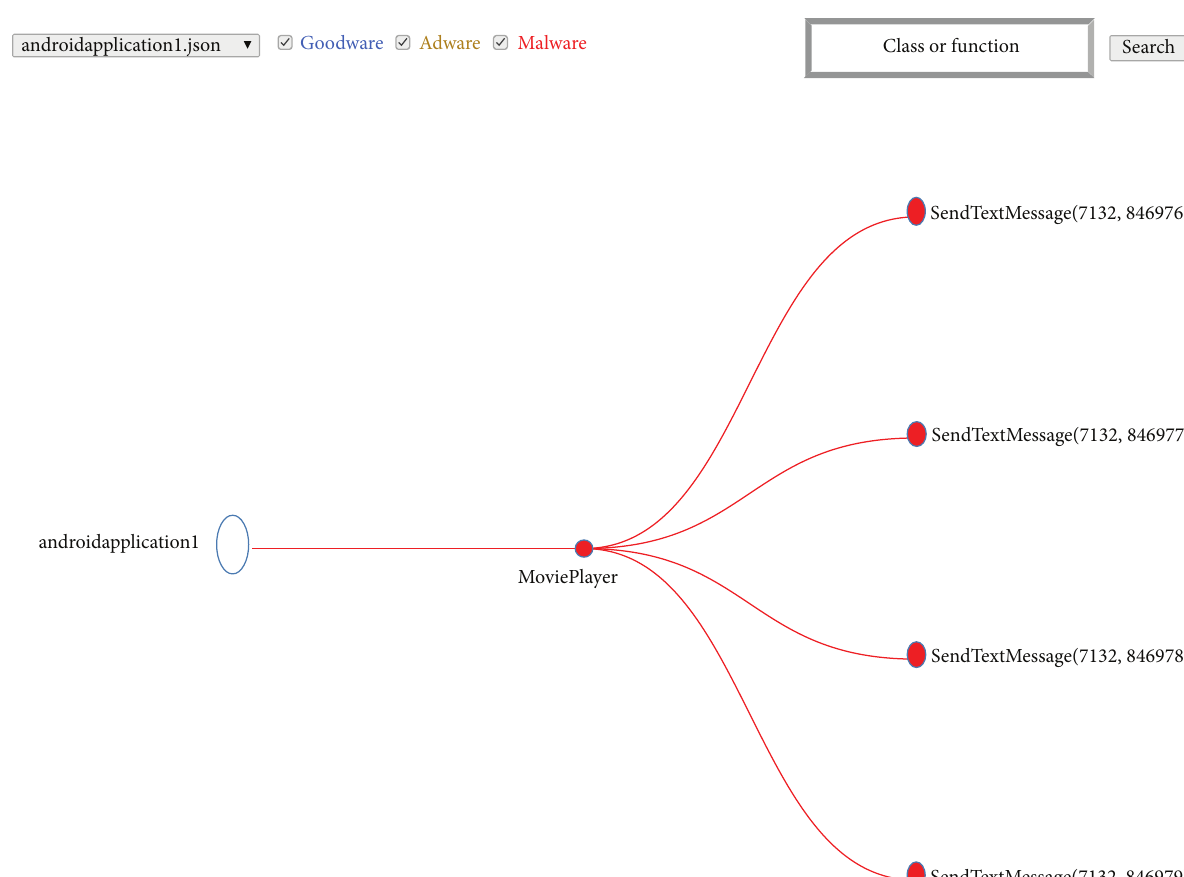
Figure 4: The simplified dendrogram of the malware FlakePlayer has been generated using the D3. Note that at the upper left corner of the figure there is a combobox to select the monitored malware (here, for simplicity, we use a shortened version of package name of the app, i.e., androidapplication1 ). Besides, lining up to the right of the combobox, there are three activated checkboxes, labeled as Goodware in blue, Adware in orange, and Malware in red. Also, at the upper right corner of the figure, there is a search button that allows us to look for classes or functions. The complete package name of the malware FakePlayer is org . me . androidapplication1 . MoviePlayer